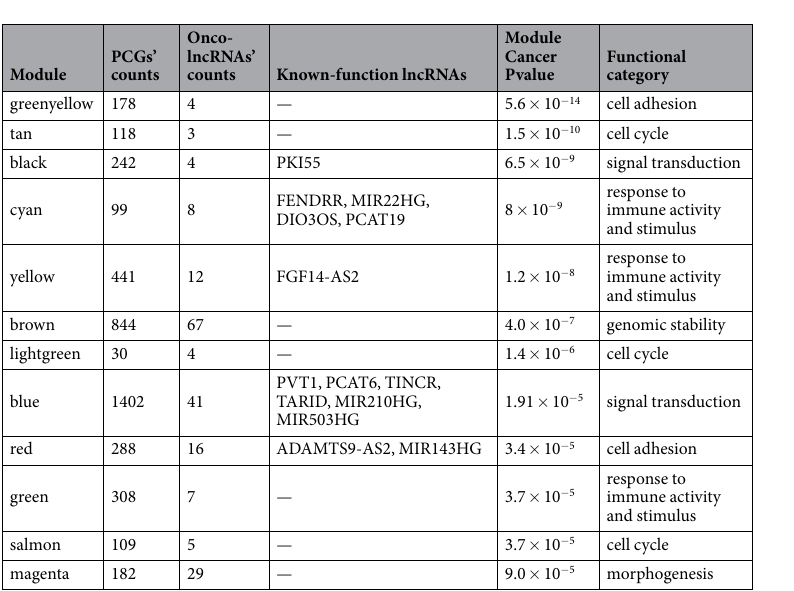
Table 1. Overview of 12 cancer-associated